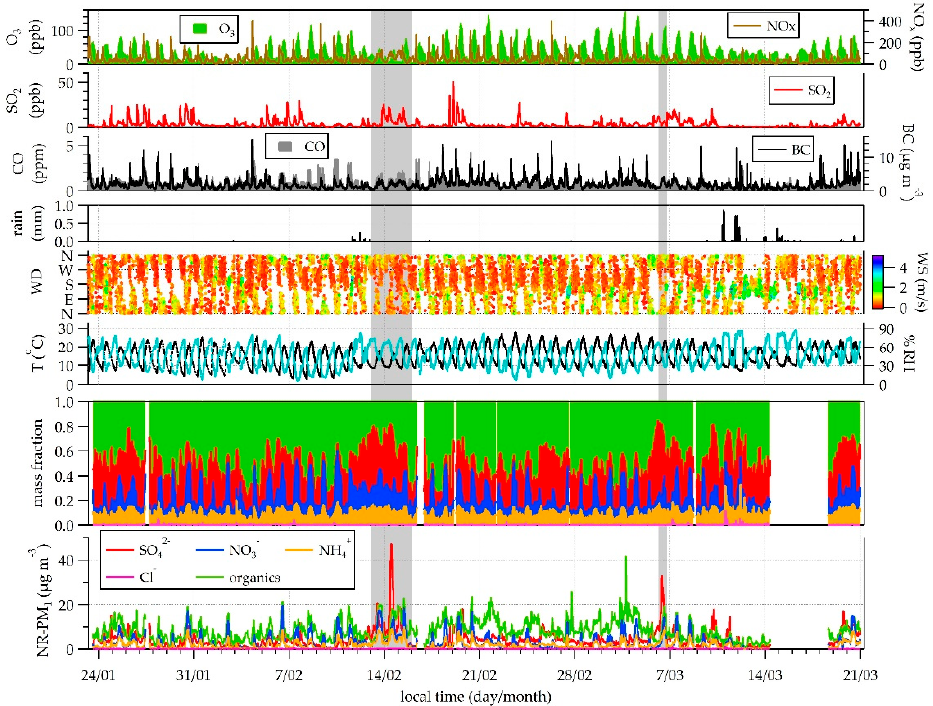
Figure 2. Time series of the mass concentration and fraction of the non-refractory submicron particulate matter (NR-PM 1 ) components (organics, sulfate, nitrate, ammonium, and chloride), meteorological variables (temperature (T), relative humidity (RH), wind speed (WS) and direction (WD), and rain), black carbon (BC), and other pollutants (CO, SO 2 , O 3 , and NOx) during ACU15. The gray area highlights the acidic periods mentioned in Section 3.3. ACU15: Aerosoles en Ciudad Universitaria 2015.